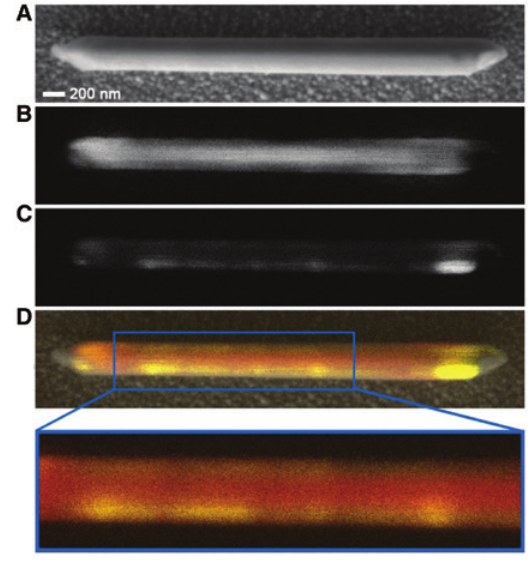
Figure 8: (A) FE-SEM micrograph of the nanowire whose spectrum is reported in Figure 1C (the 200 nm marker holds also for CL images); (B and C) energy-selected CL images corresponding to the spectral intervals evidenced by the gray-hatched vertical regions in Figure 1C; and (D) color-coded (red: core; yellow: QWT) superposition of the two CL images in (B) and (C), allowing a better visualization of the spatial localization of the QWT